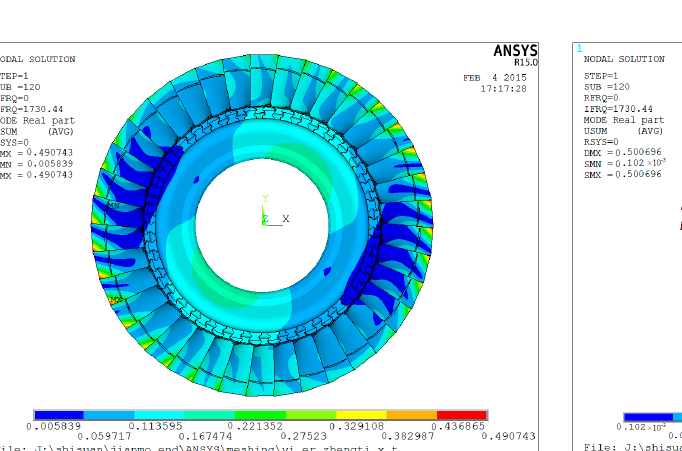
Figure 34. Mode 115.